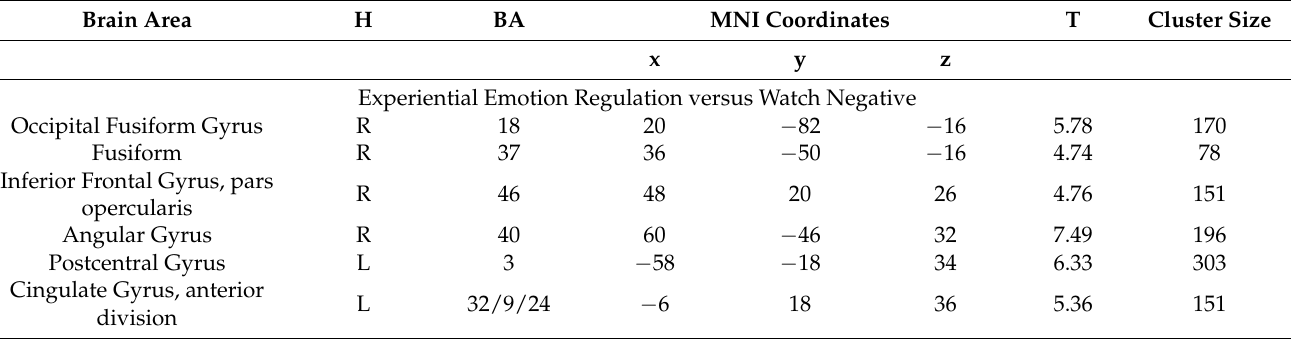
Table 4. Activations for experiential emotion regulation and cognitive defusion versus emotional pictures in the watch condition.